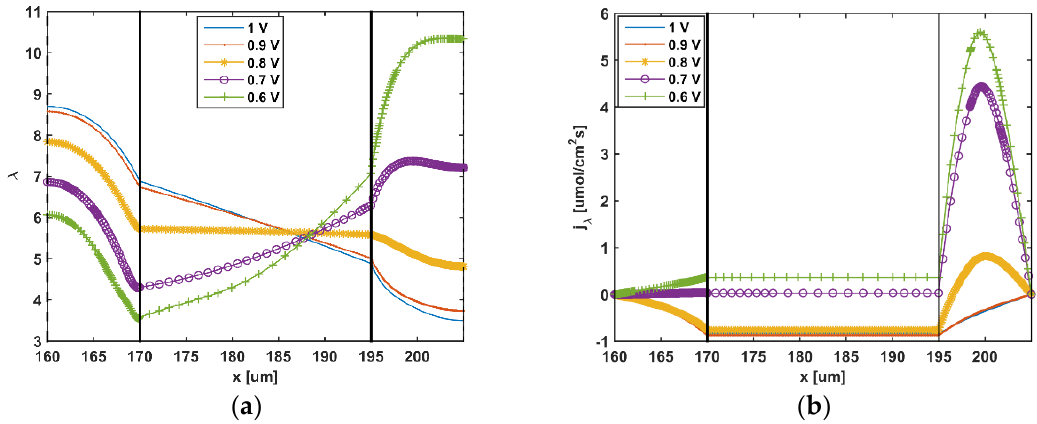
Figure 10. Profiles of water transport in ionomer: ( a ) prediction of the water content of membrane in different domains; ( b ) prediction of the flux of water content of membrane in different domains.